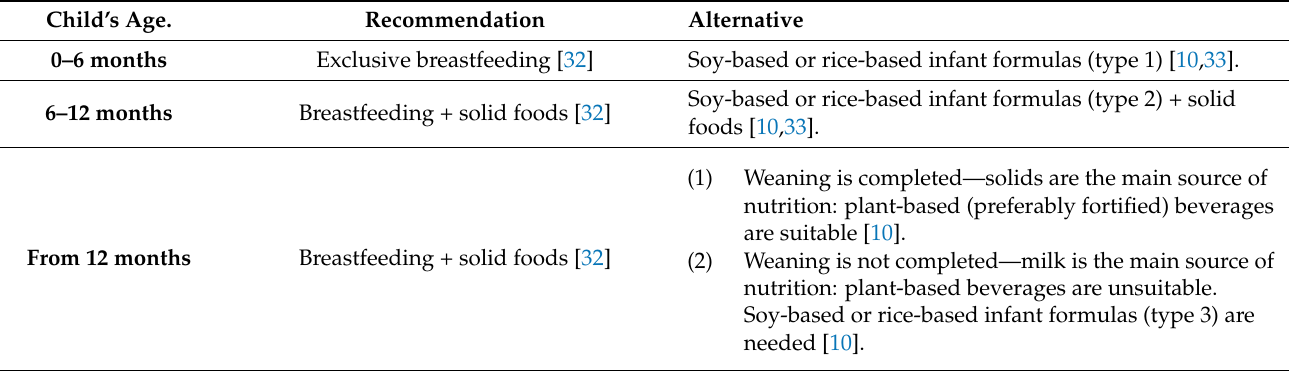
Table 6. Feeding time: recommendations and plant-based alternatives to human (or cow) milk depending on child’s age and development. Child’s